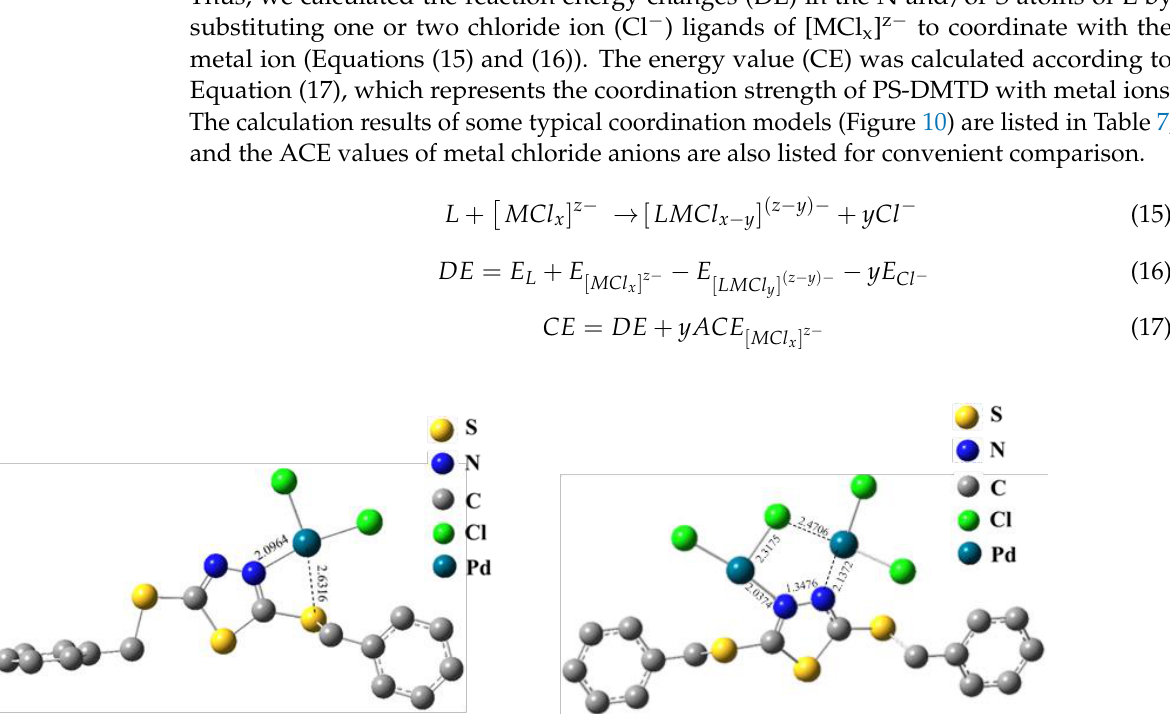
Table 6. The average coordination energy (in kcal/mol) of metal cation with chloridion in complex [MClx]-z (at B3LYP/def2-QZVP level).